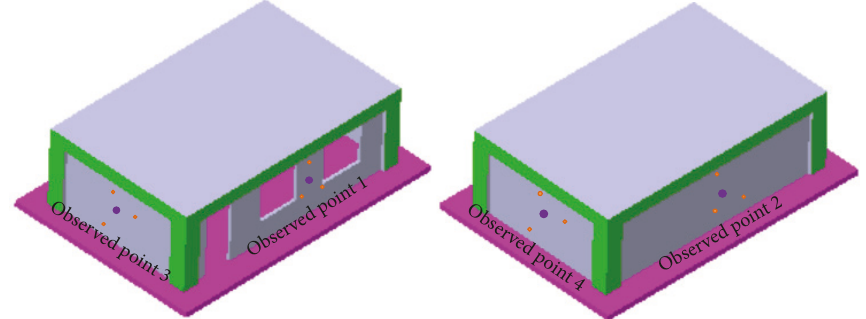
Figure 5: The observed points on the masonry